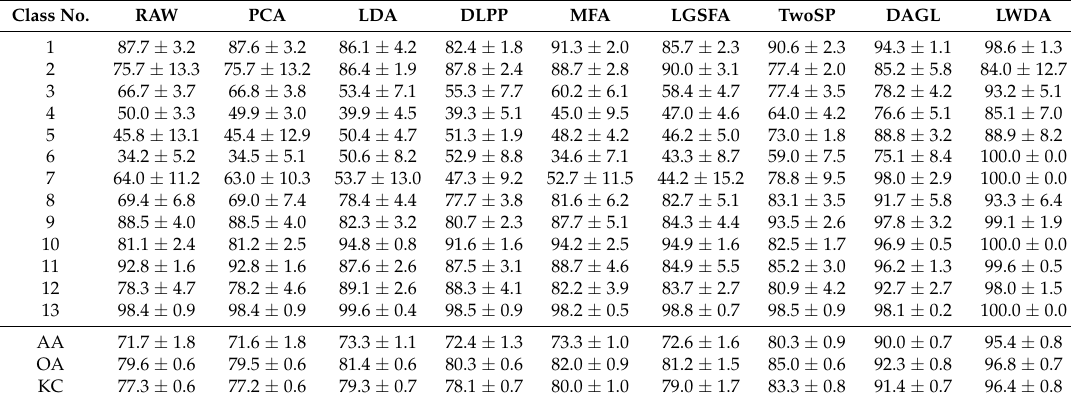
Table 3. Classification results (%) of each class ( τ = 0.05) with NN classifier on the KSC dataset. Class